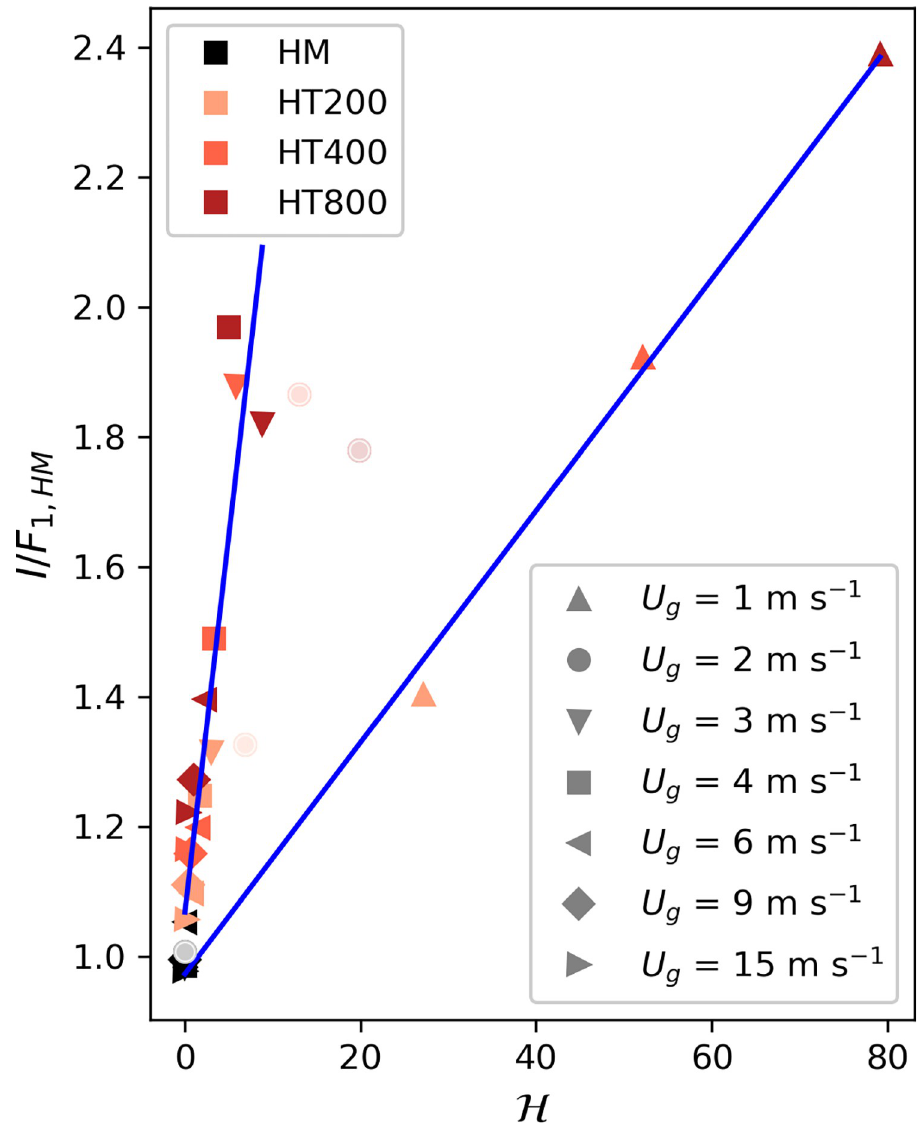
Fig 4. Dependence of the imbalances at 0.04 zi all normalized with the same scaling function F1,HM (Eq 11, Table 1) on the heterogeneity parameter H . The data is separated into two groups: (1) simulations with U g = 1 m s -1 that show cellular shaped secondary circulations and (2) simulations with U shaped secondary circulations. Simulations with U g = 2 m s -1 are discarded because they show no clearly cellular nor roll-shaped structures. The two blue lines show the fits of the third scaling function to the two groups (F 3,c and F 3,r , Eqs